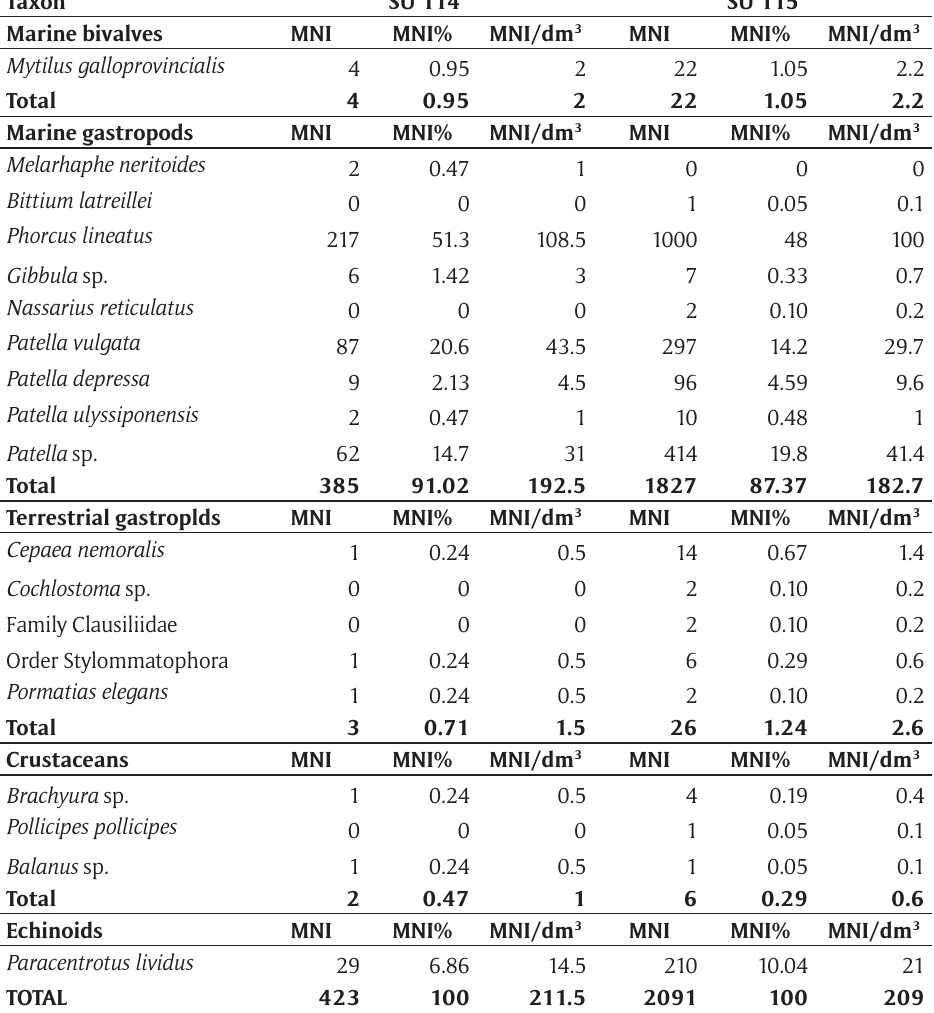
Table 2: Species representation in units 114 and 115 of El Mazo. MNI: Minimum Number of